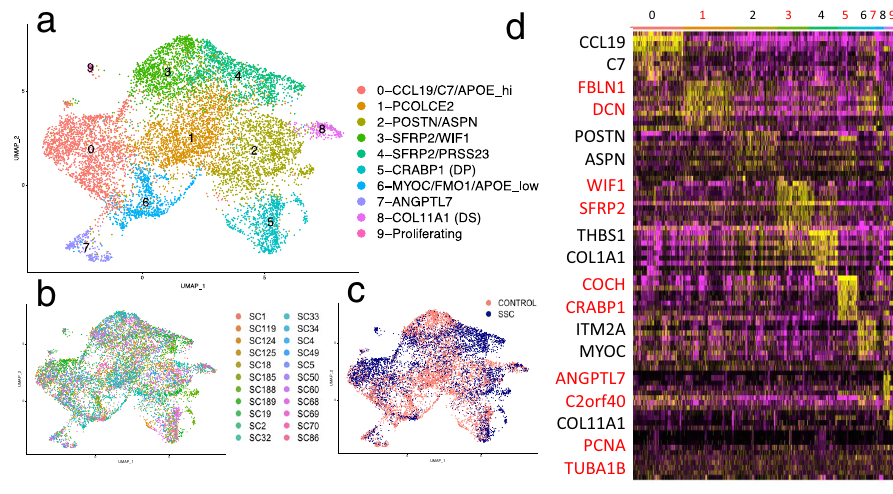
Fig. 2 UMAP plot of scRNA-seq reclustering of fi broblasts and heatmap of subclusters. UMAP analysis of transcriptomes of fi broblasts (clusters 3, 8, 10, 12, 17, and 26 from Fig. 1) from 10 healthy control and 12 SSc subjects, showing each SLM cluster by color ( a ) or by source from each patient ( b ) or by source form SSC (blue) or control (red) biopsies ( c ). Clustering of showing most differentially expressed genes associated with UMAP clusters. Yellow indicates increased expression, purple lower expression. Key marker genes are enlarged to the left ( d ).